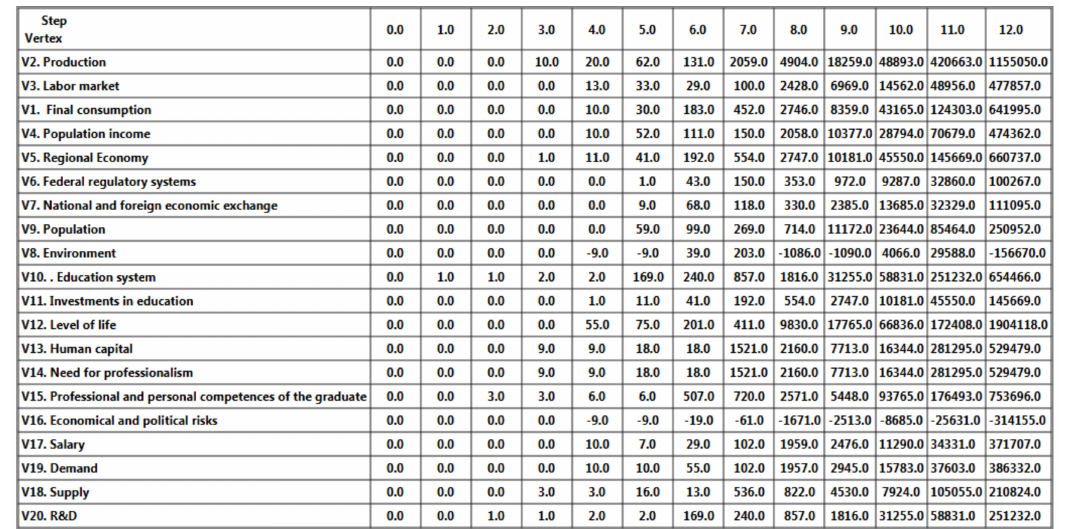
Figure 7. Scenario "Improving the conditions of higher education system in the region" disturbing momentum q10 = + (fragment from the computer data processing results on the program CMSS).